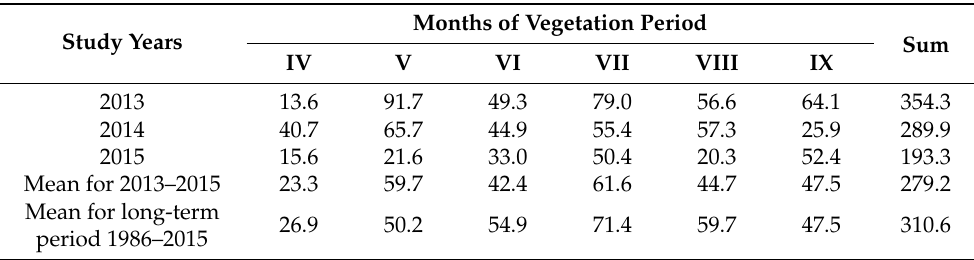
Table 2. Precipitation (mm) data during the vegetation period of Melba and Seledyn melon cultivars in the years